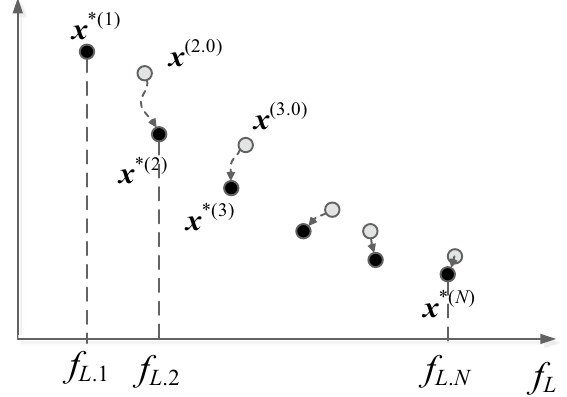
Figure 2. Graphical illustration of the Pareto set for CP antenna, representing the best possible trade-off solutions with respect to the lower operating frequency and antenna size. The black circles mark the final designs, whereas the gray circles are the initial points obtained using the procedure